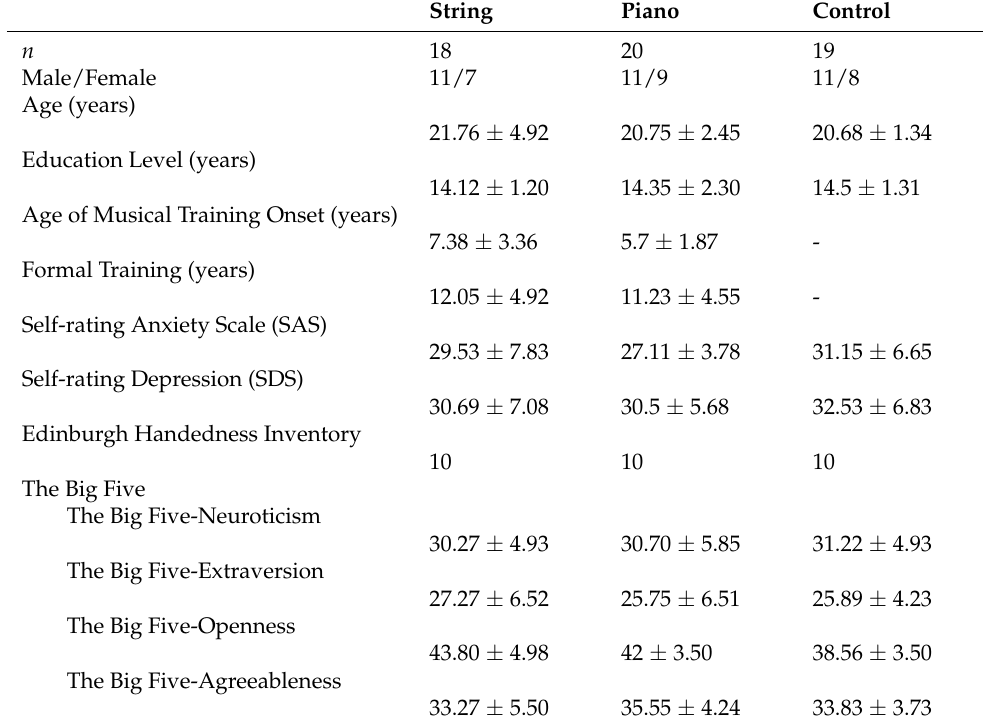
Table 1. Participant Demographics. The control group was formed with people with no musical experience, and similar ages and educational levels with the experimental groups ( p > 0.05). Musicians are guaranteed to conduct music training continuously in recent five years. The string musicians and pianists do not significantly differ in these three indexes ( p > 0.05). The scores of the Self-rating Anxiety Scale (SAS), Self-rating Depression Scale (SDS), Edinburgh Handedness Inventory, The Big Five, and Barcelona Music Reward Questionnaire (BMRQ) all show no significant difference among three groups. String Piano